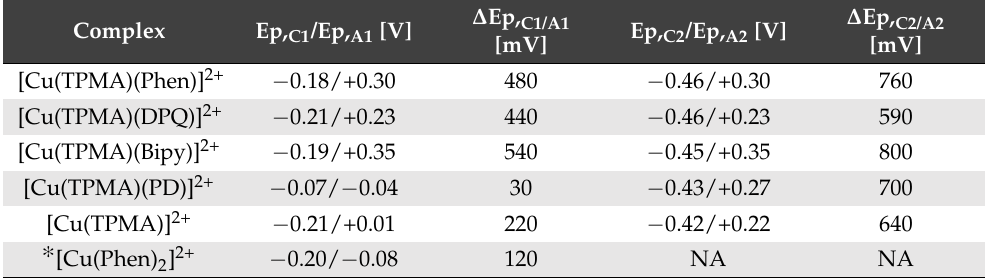
Table 1. The values of C 1 /A 1 and C 2 /A 2 redox couple anodic and cathodic peak potentials at bare gold